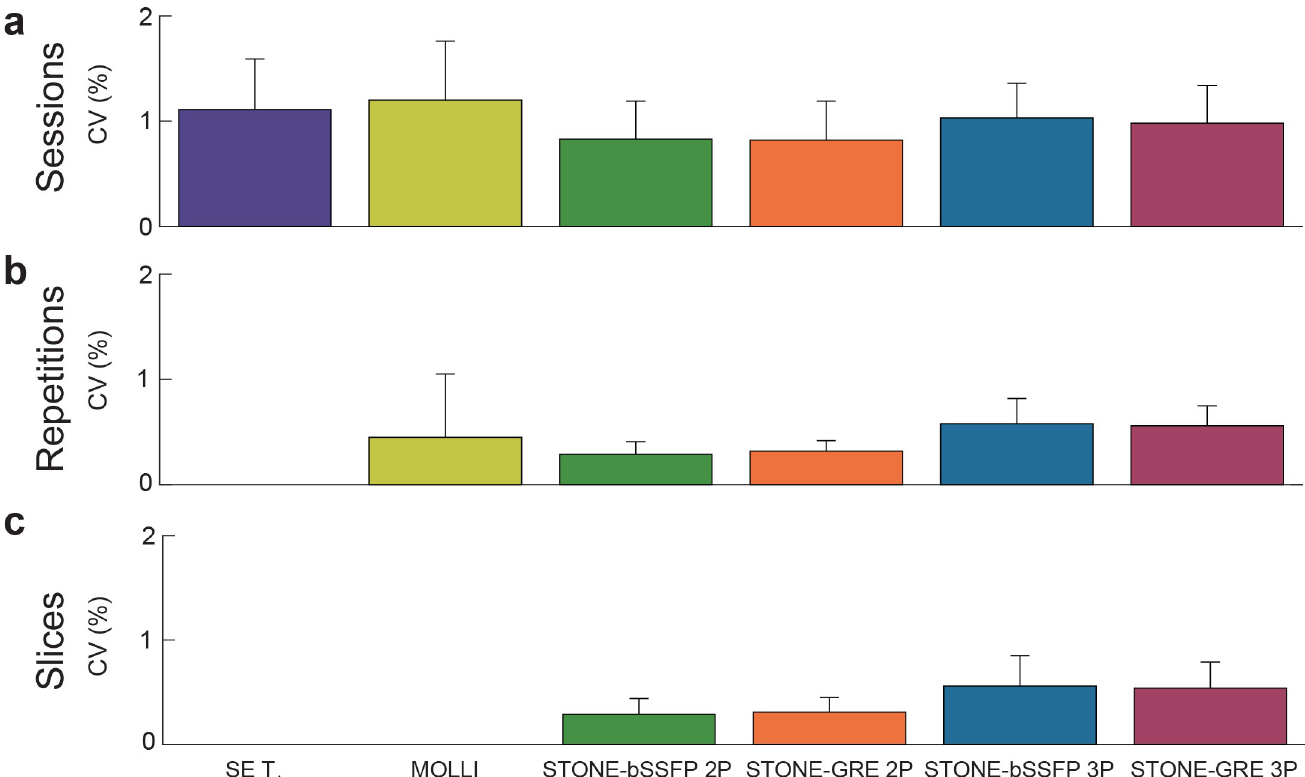
Fig 2. Reproducibility between sessions, and repeatability between repetitions and slices of slice-interleaved T 1 mapping sequences were assessed using coefficients of variation (CV). Slice-interleaved T 1 mapping sequences showed excellent between-session reproducibility (CV: SE T 1 = 1.1 ± 0.5%, MOLLI = 1.2 ± 0.6%, STONE-bSSFP 2P = 0.8 ± 0.4%, STONE-GRE 2P = 0.8 ± 0.4%, STONE-bSSFP 3P = 1.0 ± 0.3%, STONE-GRE 3P = 1.0 ± 0.4%), between-repetition repeatability (CV: MOLLI = 0.5 ± 0.6%, STONE-bSSFP 2P = 0.3 ± 0.1%, STONE-GRE 2P = 0.3 ± 0.1%, STONE-bSSFP 3P = 0.6 ± 0.2%, STONE-GRE 3P = 0.6 ± 0.2%), and between- slice repeatability (CV: STONE-bSSFP 2P = 0.3 ± 0.2%, STONE-GRE 2P = 0.3 ± 0.1%, STONE-bSSFP 3P = 0.6 ± 0.3%, STONE-GRE 3P = 0.5 ± 0.3%).